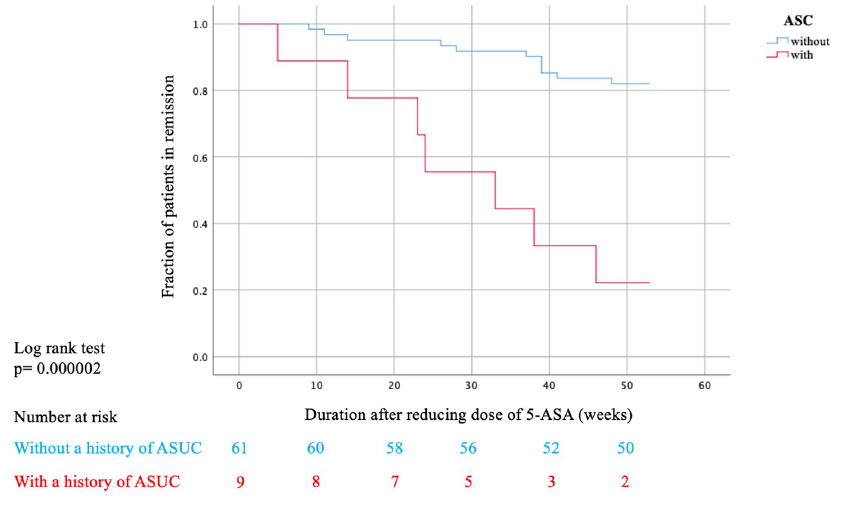
Fig 2. Cumulative relapse-free survival rate with and without a history of ASUC.